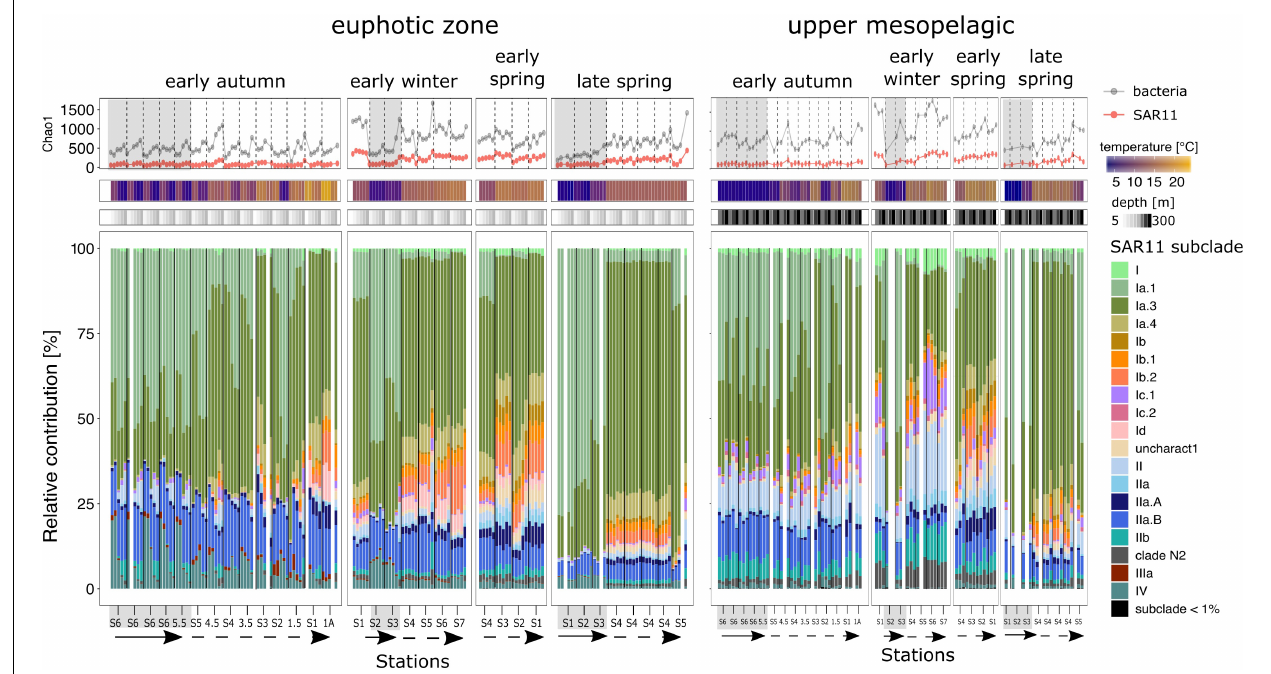
FIGURE 6 | SAR11 richness (Chao1) and stacked bar plots of the subclades relative contributions for each station within each seasonal campaign. Top panel represent the richness (Chao 1 index) of the bacterioplankton fraction (gray line) and the specific to SAR11 ASVs (red line). Base barplots depict the relative contributions of the SAR11 subclades in the euphotic zone (left side) and the upper mesopelagic (right side). Bars are organized by station from left to right in a north to south direction indicated by the straight arrow (subpolar) and the dashed arrow (subpolar), except early winter where S2 was the most northern station. Within each station, depths are organized in a descending order. Blank columns represent samples that did not overcame the minimal sequences threshold or which sample was unsuccessful to generate amplicon sequences. Gray background shading indicates that the profile is biologically categorized as subpolar, while no shades represents subtropical.